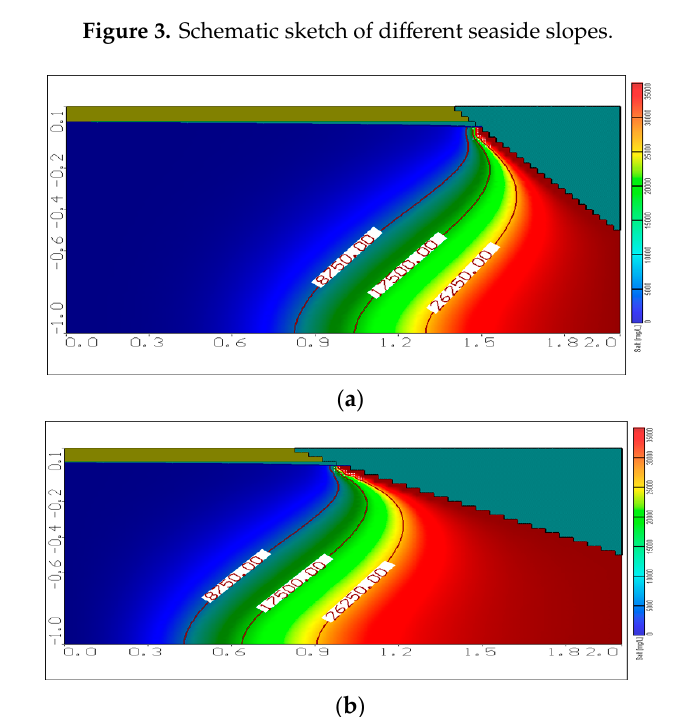
Figure 4. Saltwater intrusion for seaside slope ( a ) 1:1 and ( b ) 2:1.